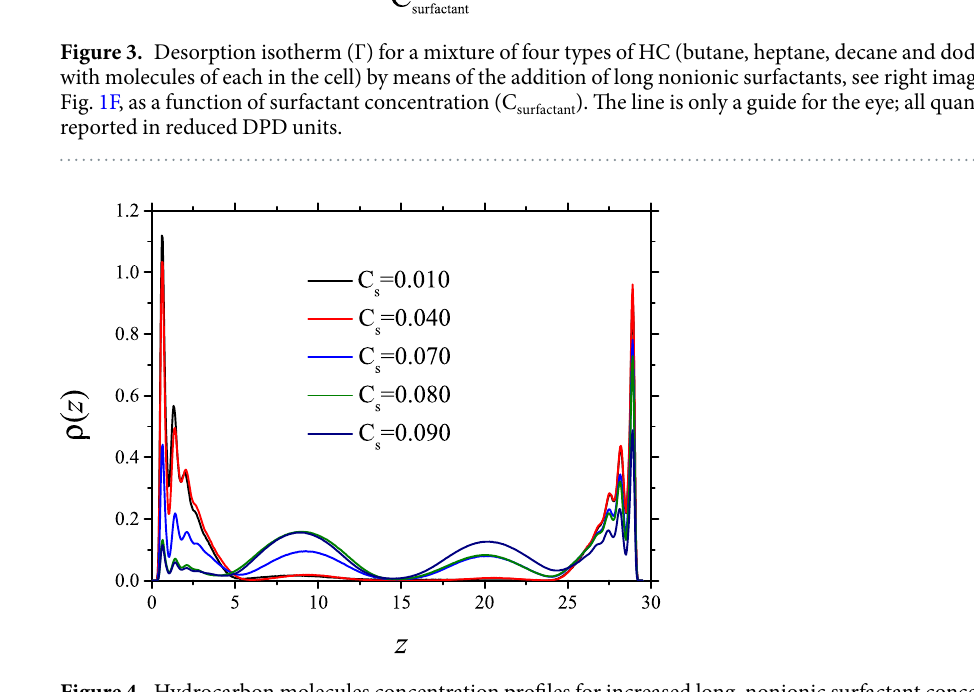
Figure 4. Hydrocarbon molecules concentration profiles for increased long, nonionic surfactant concentration. At low surfactant concentration (C s ) no desorption is observed, but as C s is increased the HC begin to desorb, see the blue line. All quantities are reported in reduced DPD